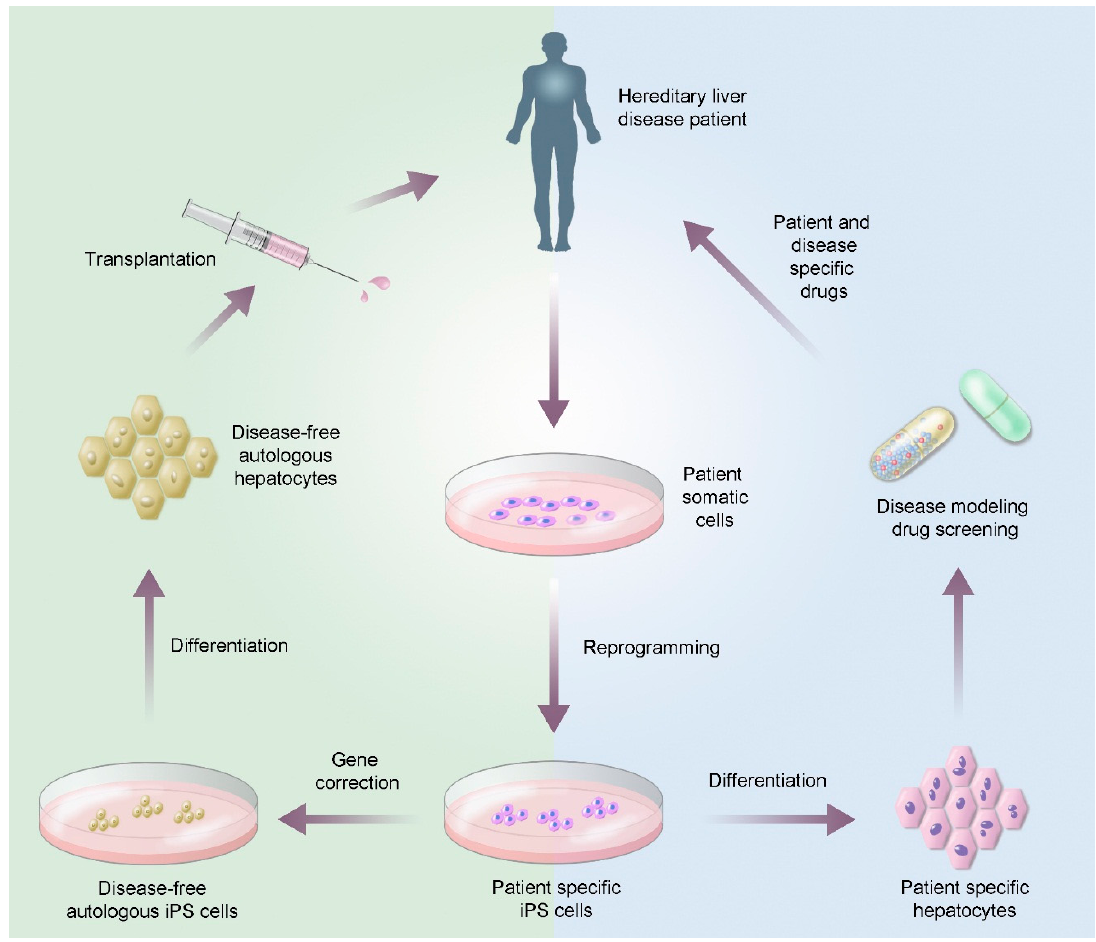
Figure 3. Gene correction of iPSC for the production of patient-specific disease-free hepatocytes.